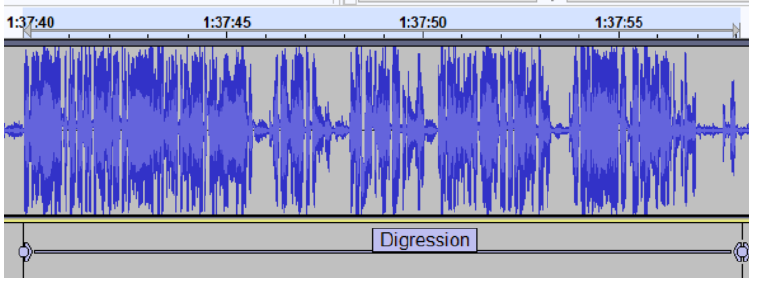
Figure 3. Audio sample of a Digression segment. Table 2. Transcription of Figure 3.